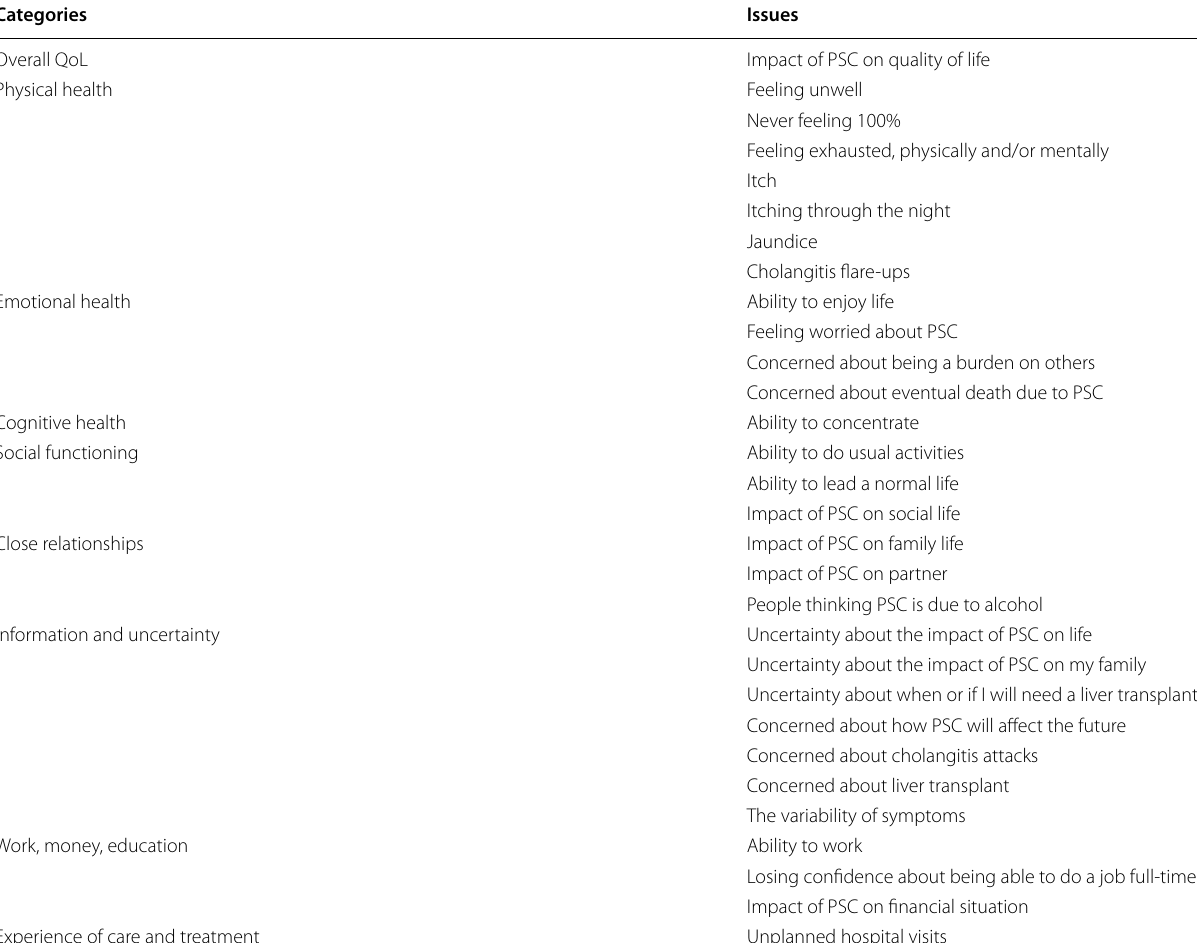
60% PSC participants ≥